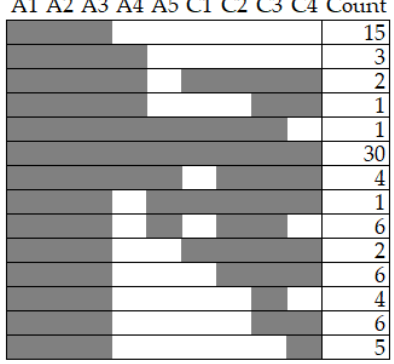
Figure 4. Characterization of included life cycle modules in the sample of EPDs. A total of 14 different types of scopes were found in the overall sample of EPDs.